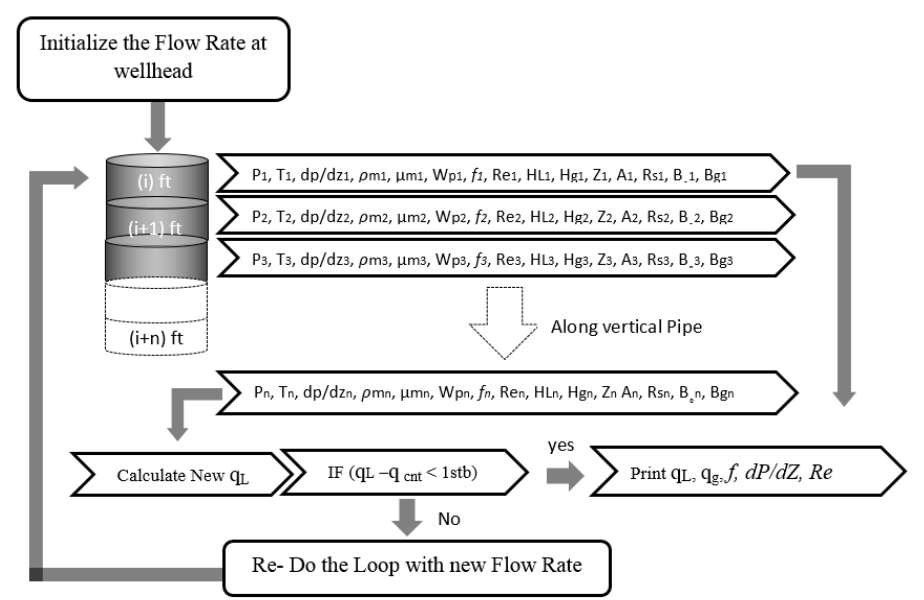
Figure 6. Flow diagram of new computational method procedure.